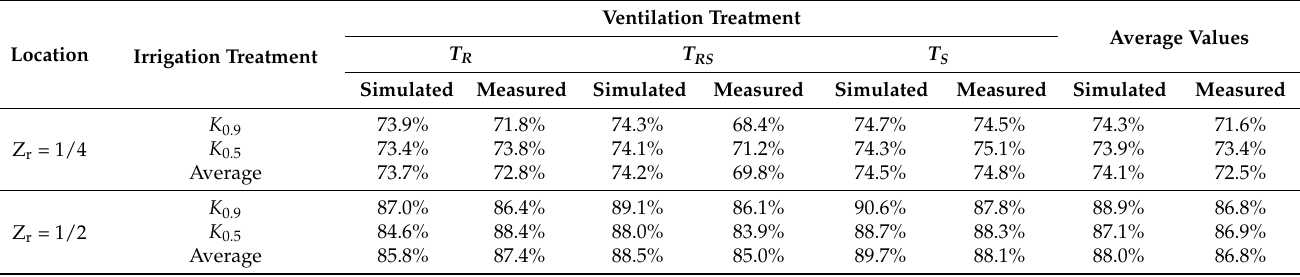
Table 4. Estimating the proportion of greenhouse tomato roots allocated in